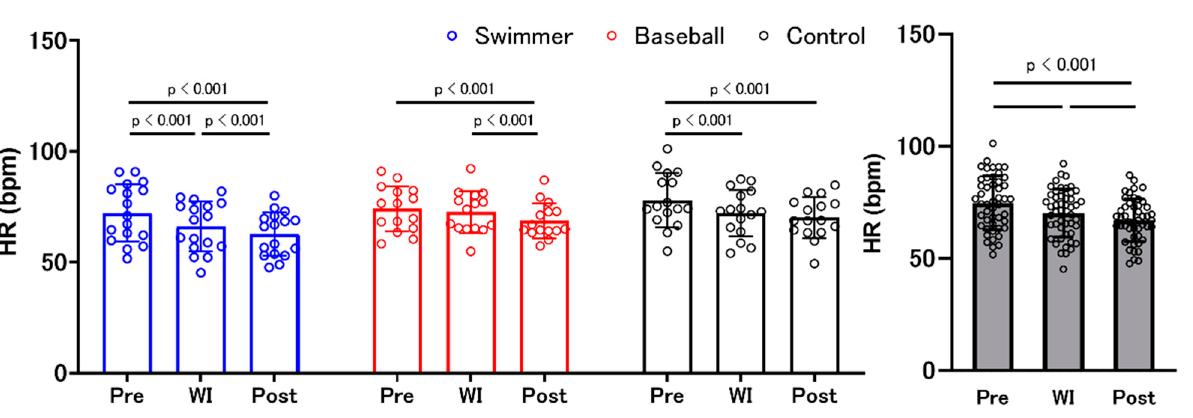
Figure 5. Changes in heart rate. Blue, red, and black bars indicate the swimmer, baseball, and control groups, respectively. Gray bars represent all participants with individual data (open circles). Heart rate (HR) significantly decreased at post compared to that at pre in all groups, during water immersion (WI) compared to that at pre in swimmer and control groups, and at post compared to that during WI in swimmer and baseball groups.